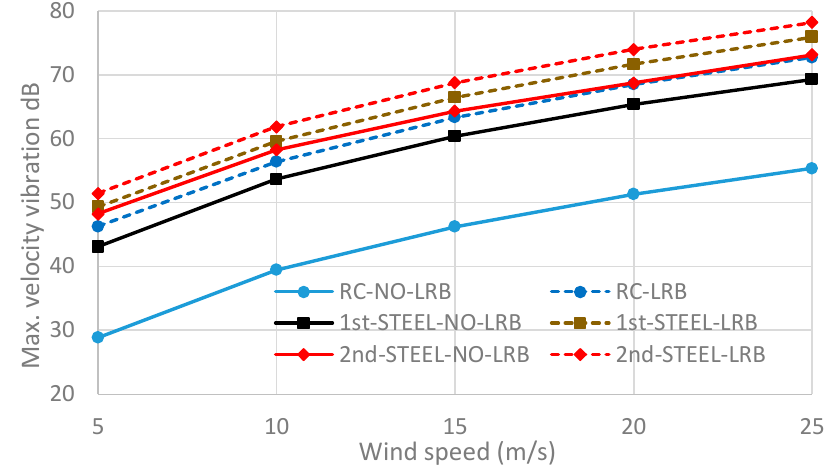
Figure 13. Maximum velocity vibration dB at the first to third floors under the wind load with the average wind speed from 5 to 25 m/s for the factory with or without LRBs.